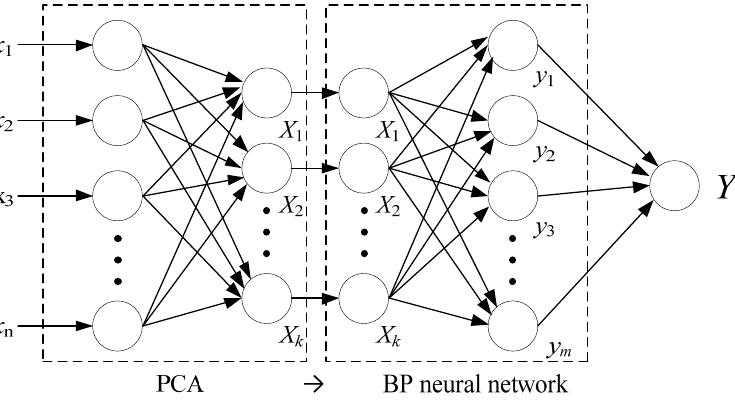
Figure 5. The prediction model based on the BP neural network combined with the PCA method.